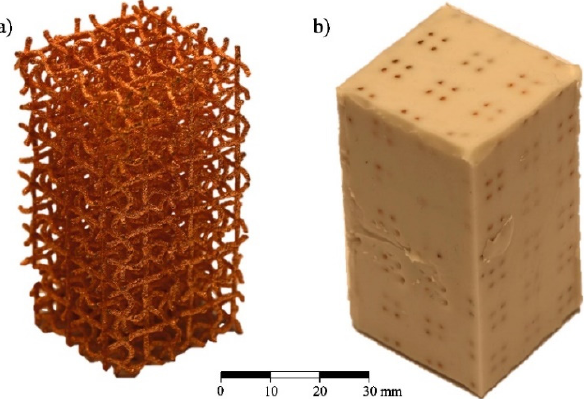
Figure 32. A uniform, chiral structure made of copper shown ( a ) without and ( b ) with a rubber encasing. The hybrid composite structure ( b ) combines the initial EBM-bonded copper lattice with a silicon polymer filler while maintaining a vacuum seal of 0.5 MPa in the build chamber during fabrication [153]. (Reprinted from Composite Structures, Volume 234, N. Novak, et al., ‘Mechanical properties of hybrid metamaterial with auxetic chiral cellular structure and silicon filler’, Copyright (2020), with permission from Elsevier).